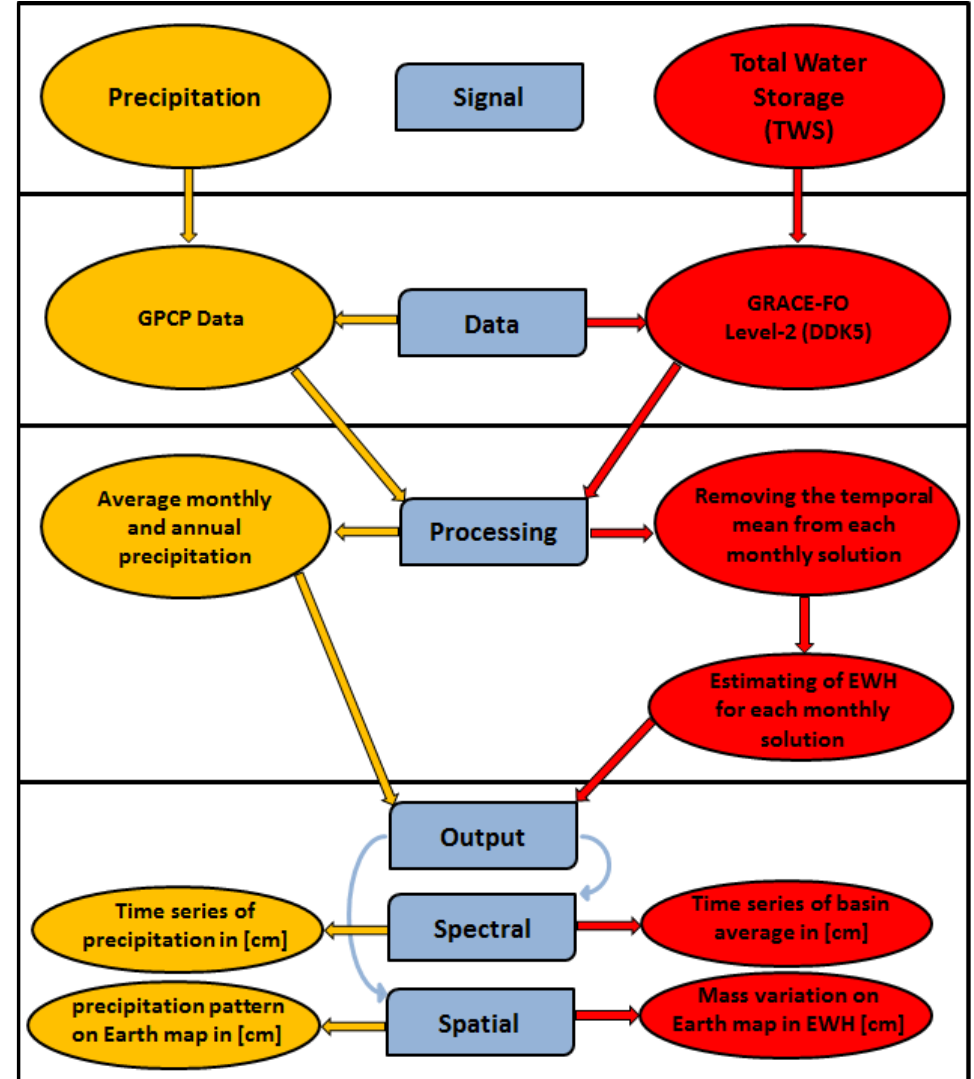
Figure 2. Flowchart describing the estimation procedure of the TWS signal in terms of EWH [cm] and the precipitation pattern.